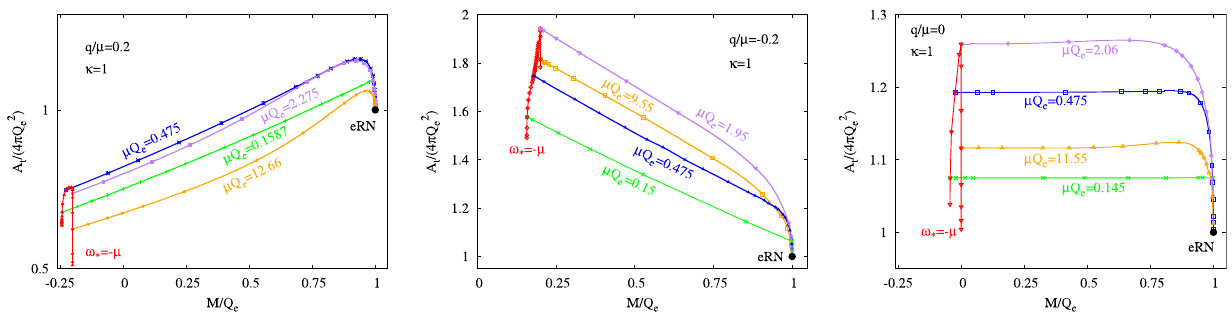
Fig. 4 Throat area scaled to the electric charge, A t /( 4 π Q 2 e ) , as a func- tion of the scaled total mass, M / Q e . Top left panel shows solutions for q /μ = 0 . 2, top right panel for q /μ = − 0 . 2, and bottom panel for q /μ = 0. Solutions with fixed scaled electric charge μ Q e are shown in